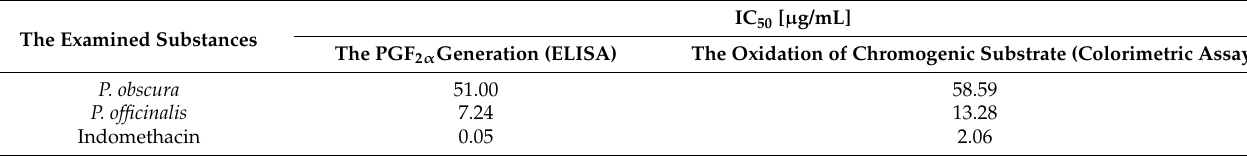
Table 6. The IC 50 values established during a screening of inhibitory actions of P. obscura and P. officinalis phenolic-rich fractions on COX-2 activity ( n = 3–4).